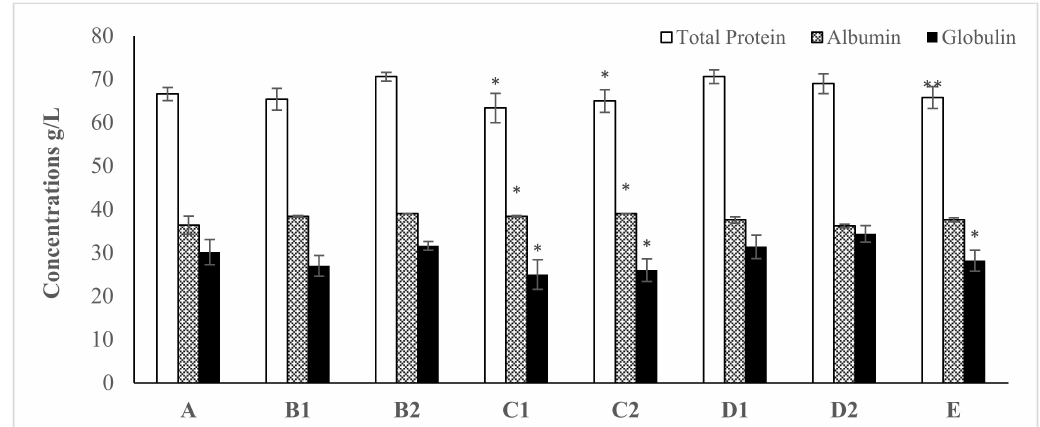
Figure 3. The effect of various concentrations of biosynthesized ZnO NPsAL on total protein albumin and globulin concentrations in rats. Data are presented as the mean ± SEM of at least n ≥ 5 replicate experiments and analyzed using one-way ANOVA followed by Newman–Keuls post hoc analysis. (*) p < 0.05; (**) p < 0.01. Abbreviations: A, Control; B1, 0.01 M ZnO NPsAL (80 mg kg − 1 ); B2, 0.01 M ZnO NPsAL (40 mg kg − 1 ); C1, 0.05 M ZnO NPsAL (80 mg kg − 1 ); C2, 0.05 M ZnO NPsAL (40 mg kg − 1 ); D1, 0.1 M ZnO NPsAL (80 mg kg − 1 ); D2, 0.1 M ZnO NPsAL (40 mg kg − 1 ); E, Zinc nitrate solution (80/40 mg kg − 1 ).